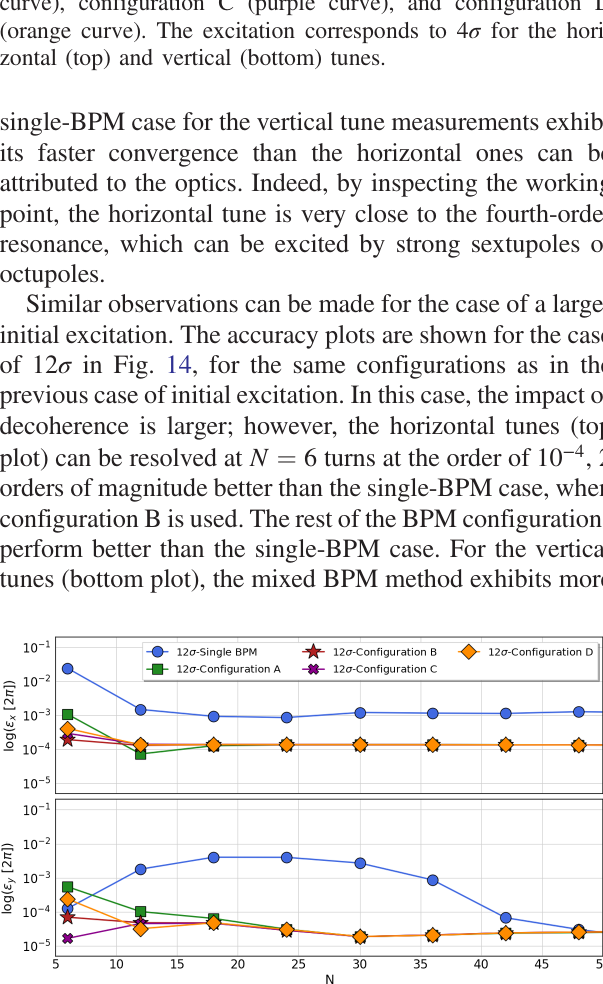
FIG. 14. Comparison of the accuracy for the tune measure- ments with single-BPM (blue curve) and mixed BPM configu- rations for configuration A (green curve), configuration B (red curve), configuration C (purple curve), and configuration D (orange curve). The excitation corresponds to 12 σ for the horizontal (top) and vertical (bottom)